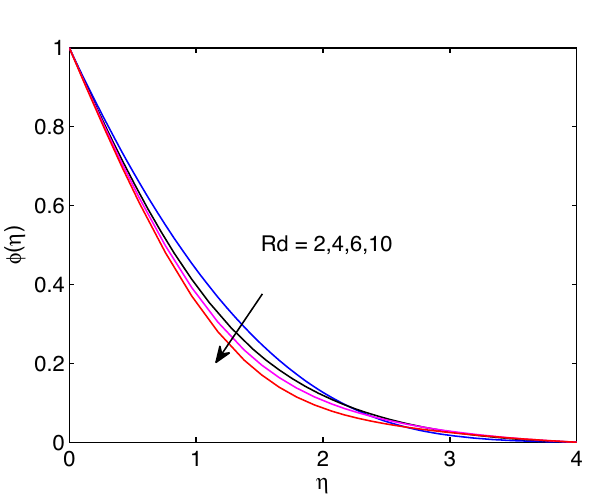
Figure 23. Thermal radiation effects on temperature profiles.